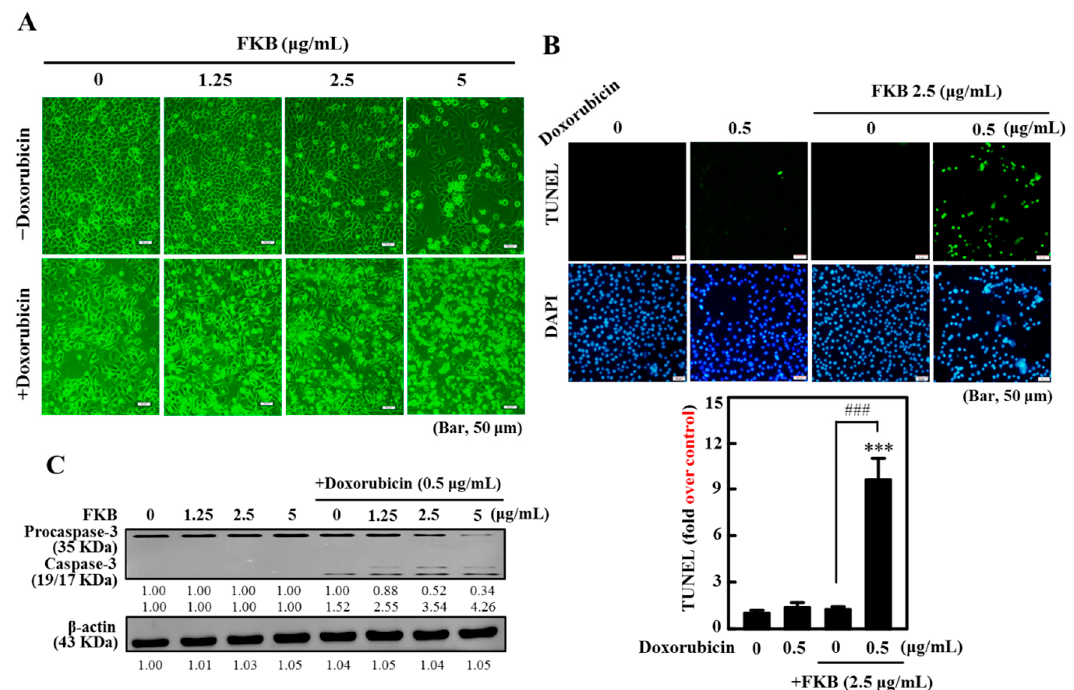
Figure 1. The synergistic effects of flavokawain B (FKB) and co-treatment with doxorubicin induced apoptosis of AGS cells in human gastric cancer. Cells have been exposed to FKB (0–2.5 µg/mL), doxorubicin (0.5 µg/mL), and a 24-h mixture of them. ( A ) Microscopy of phase-contrast (200 scale magnification) was used to investigate structural changes. ( B ) A TUNEL assay was conducted to determine the fragmentation of apoptotic DNA. The green florescence indicates the number of TUNEL-positive cells from three separate samples in the microscopic fields (Bar, 50 micron). ( C ) Western blot study of the protein content of caspase-3. It shows typical results of three independent experiments. On SDS-PAGE, the protein (50 µg) was resolved from each sample, and Western blot was performed. β -actin was used as an internal control of loads. Densitometric analysis calculated relative changes in protein bands with the control as 1.0-fold , as shown just below the gel results (Figure S1). Values were expressed as mean ± SD ( n = 3). Significant at *** p < 0.001 compared to untreated control cells. Significant at ### p < 0.001 compared to FKB-treated cells.